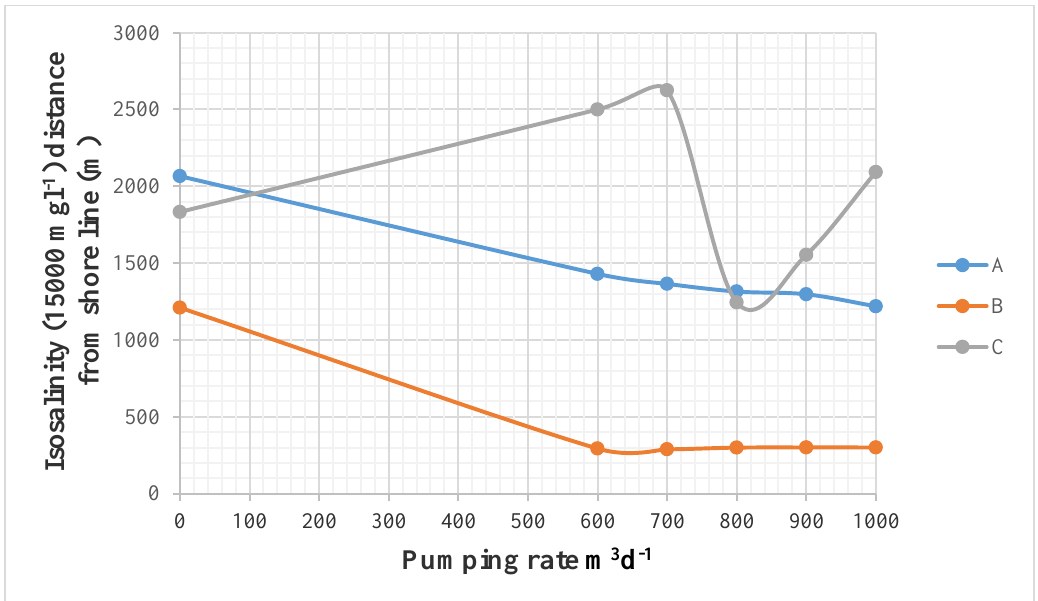
Figure 13. Location of 15,000 mgl − 1 isosalinity contour line along A, B and C at 4018 days after a variable rate of pumping.